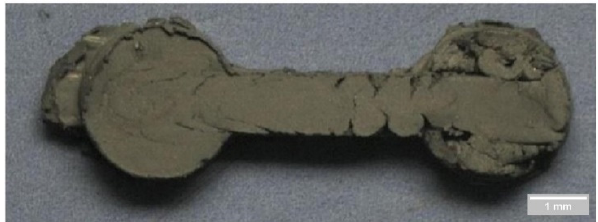
Figure 6. Jetting problem during the injection molding step. Reproduced with permission from reference [33], copyright © 2014 Elsevier B.V.